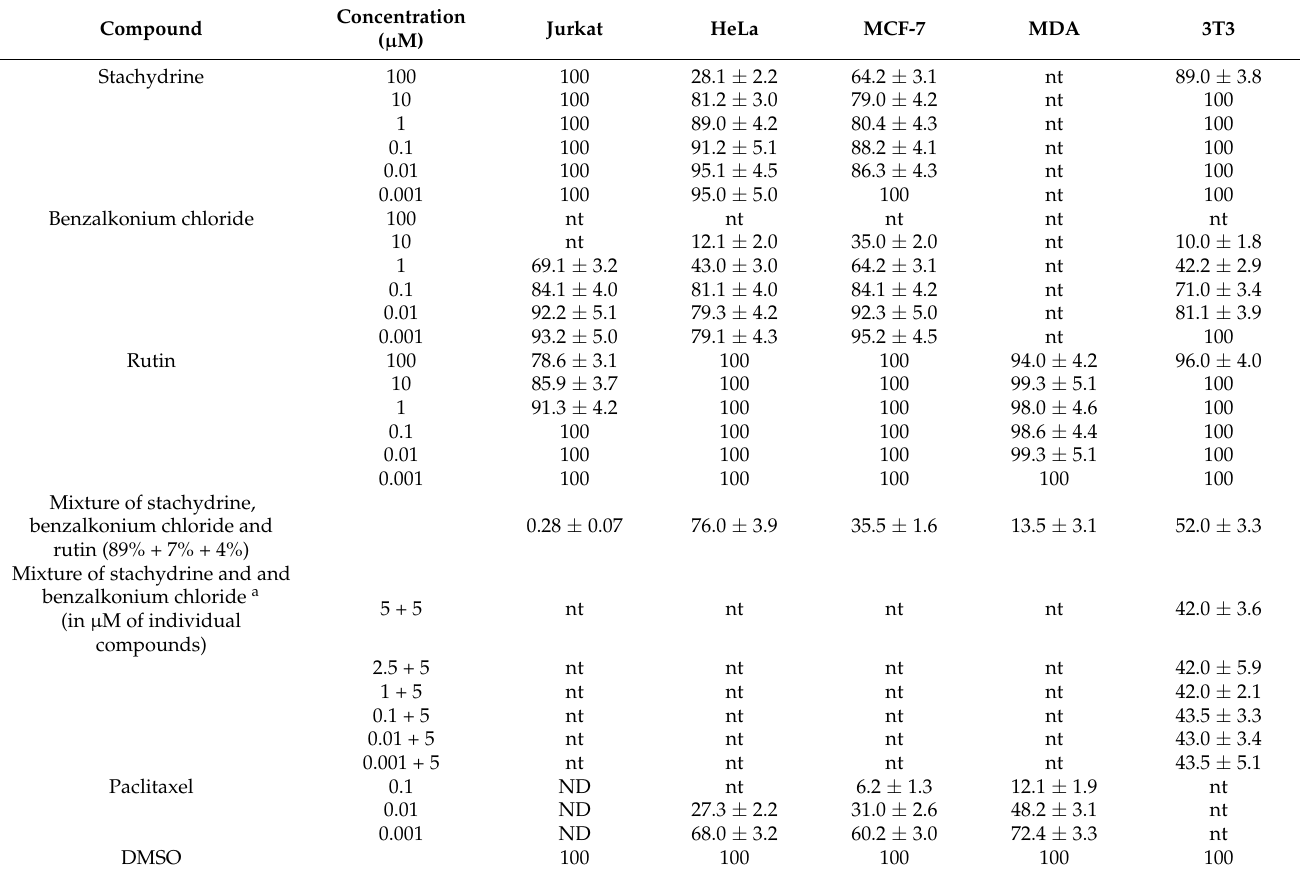
positive control. DMSO (a solvent of studied compounds) was used in a final concentration 0.02%; nt —Not